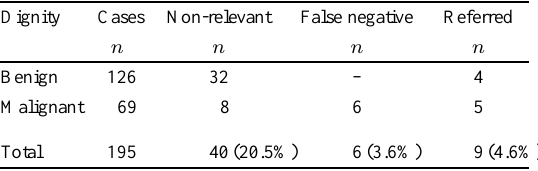
Frequency of diagnostic errors in 195 breast lesions Dignity Cases Non-relevant